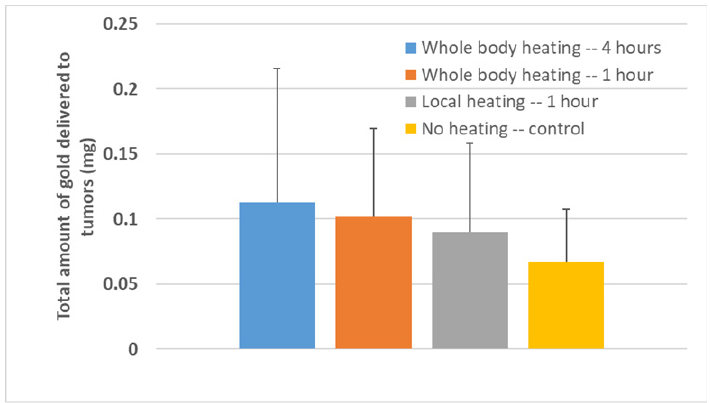
Figure 7. Mean values and standard deviations of the total amount of gold in the resected tumors in the control and heating groups.